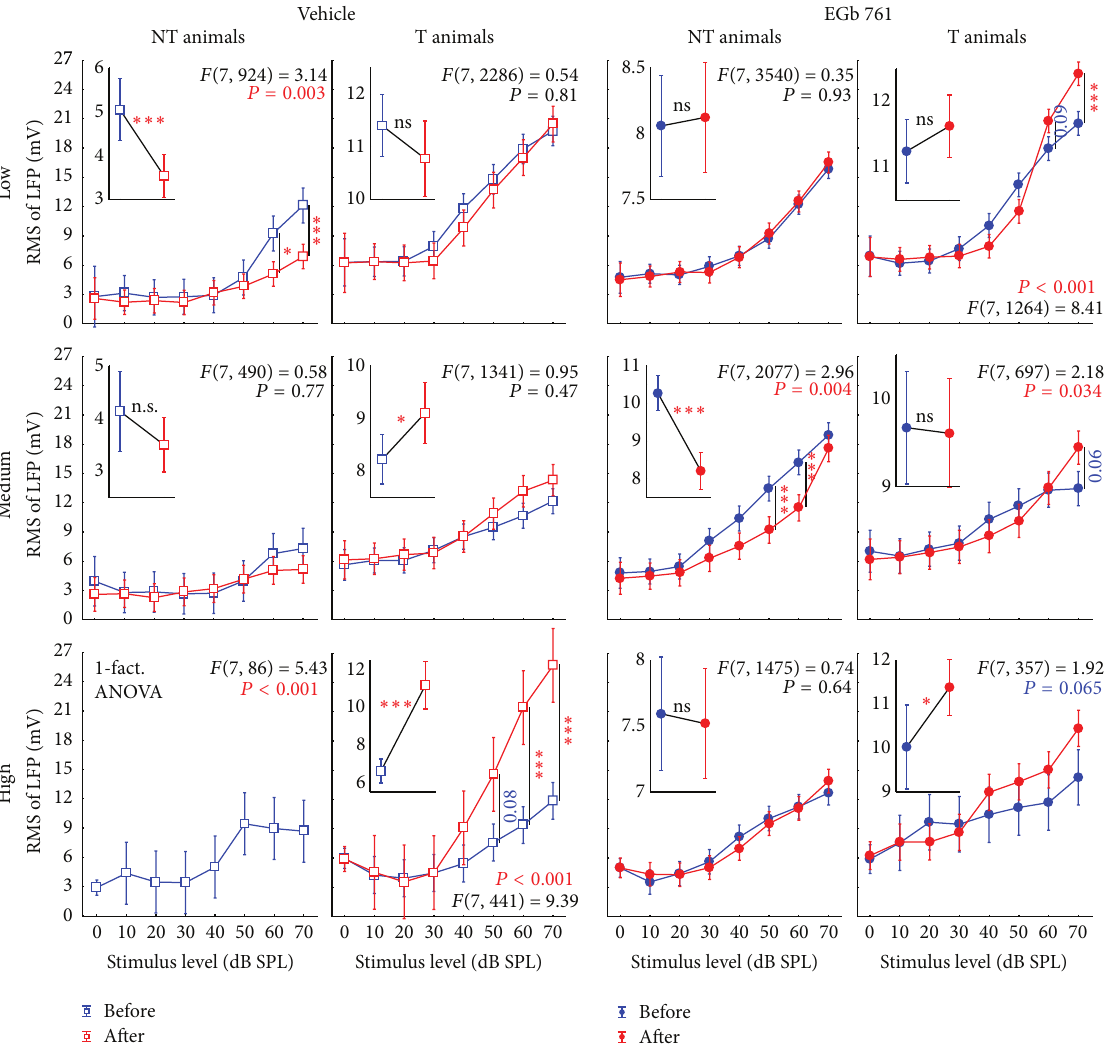
Figure 13: Level functions of the local field potential (LFP) amplitudes in the auditory cortex of NT and T animals grouped into vehicle and EGb 761 treated groups. Presented are the mean RMS values of the LFP amplitudes ( ± 95% confidence intervals) as a function of stimulus level grouped as in Figure